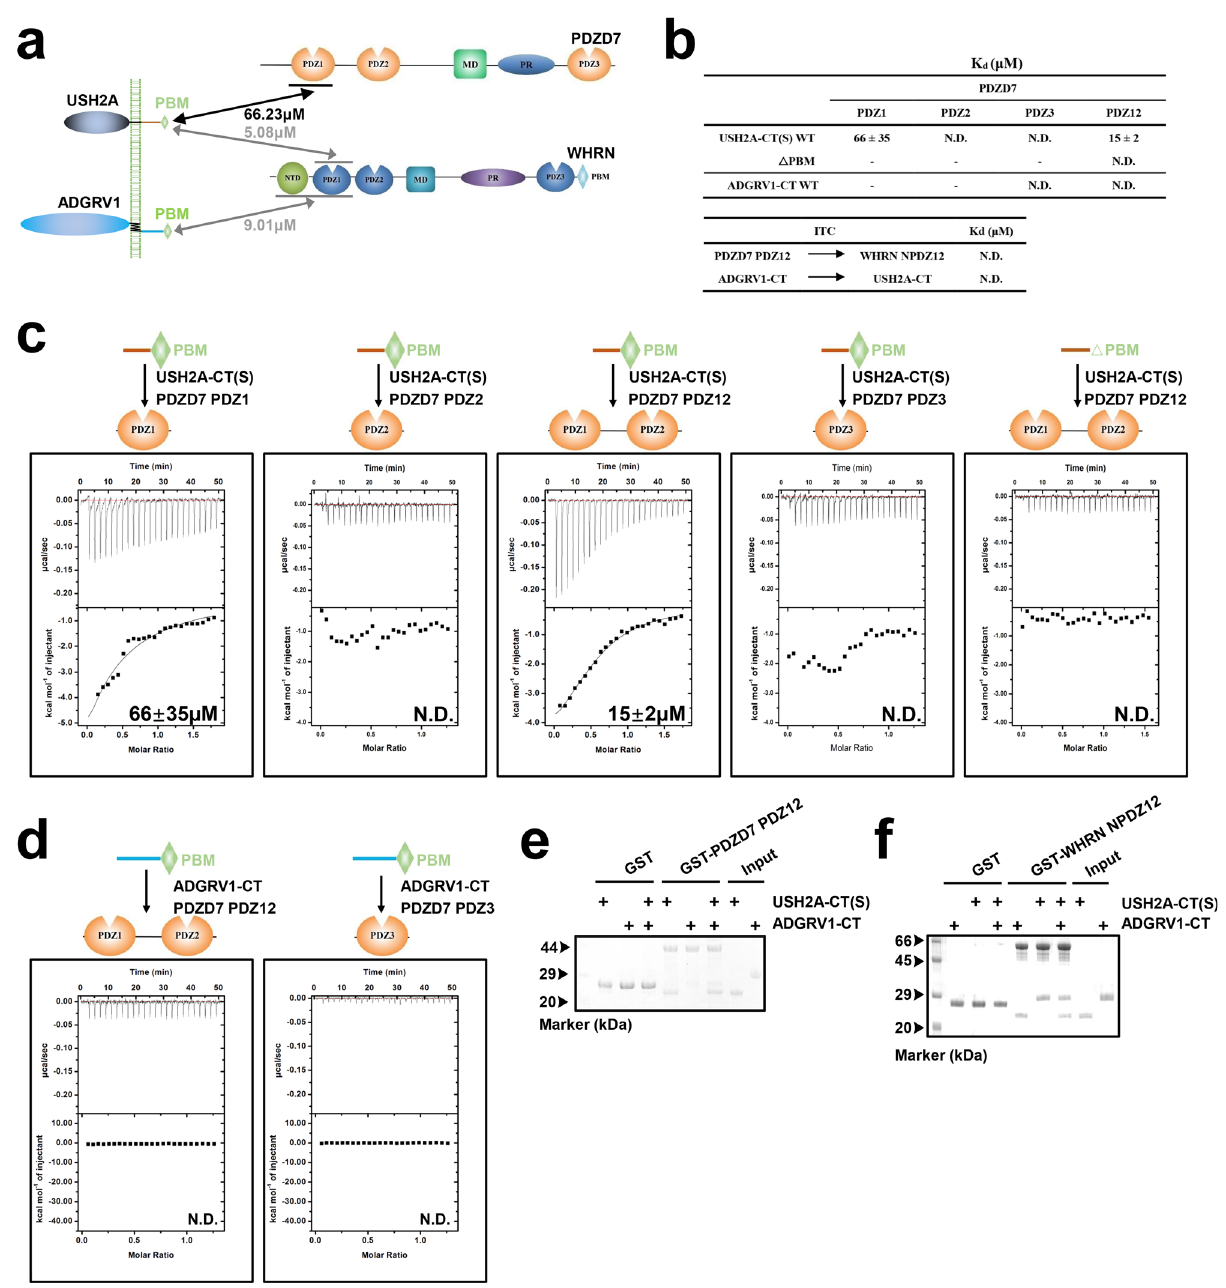
Fig. 2 | Characterization of the interactions between PDZD7 with ADGRV1 and USH2A. a The schematic diagram shows the interactions among the four USH2 proteins. b Up panel, summaries of the binding af fi nities between WT or △ PBM constructsofUSH2A-CT(S)orADGRV1-CTanddifferentPDZD7fragments;bottom panel, summaries of the binding af fi nities between PDZD7 PDZ12 and WHRN NPDZ12, ADGRV1-CT and USH2A-CT. c Binding af fi nities of USH2A-CT(S) to dif- ferent PDZD7 fragments determined by ITC. Truncating PBM ( △ PBM) from